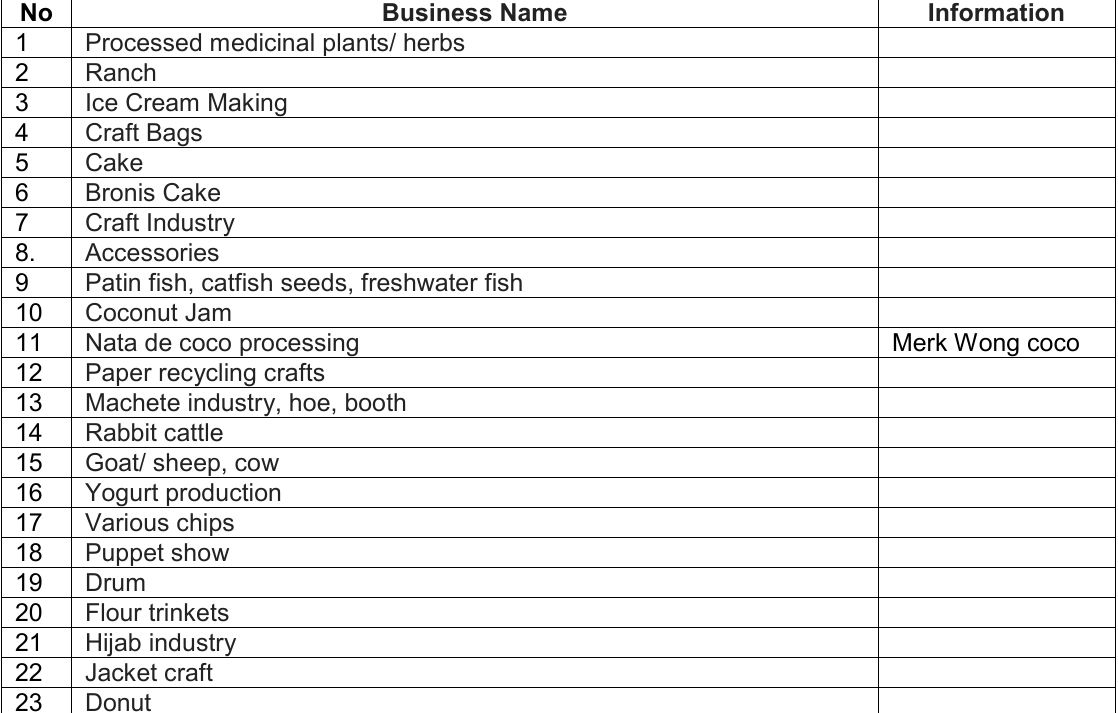
Table 1. Types of business in Tegal Waru Tourism